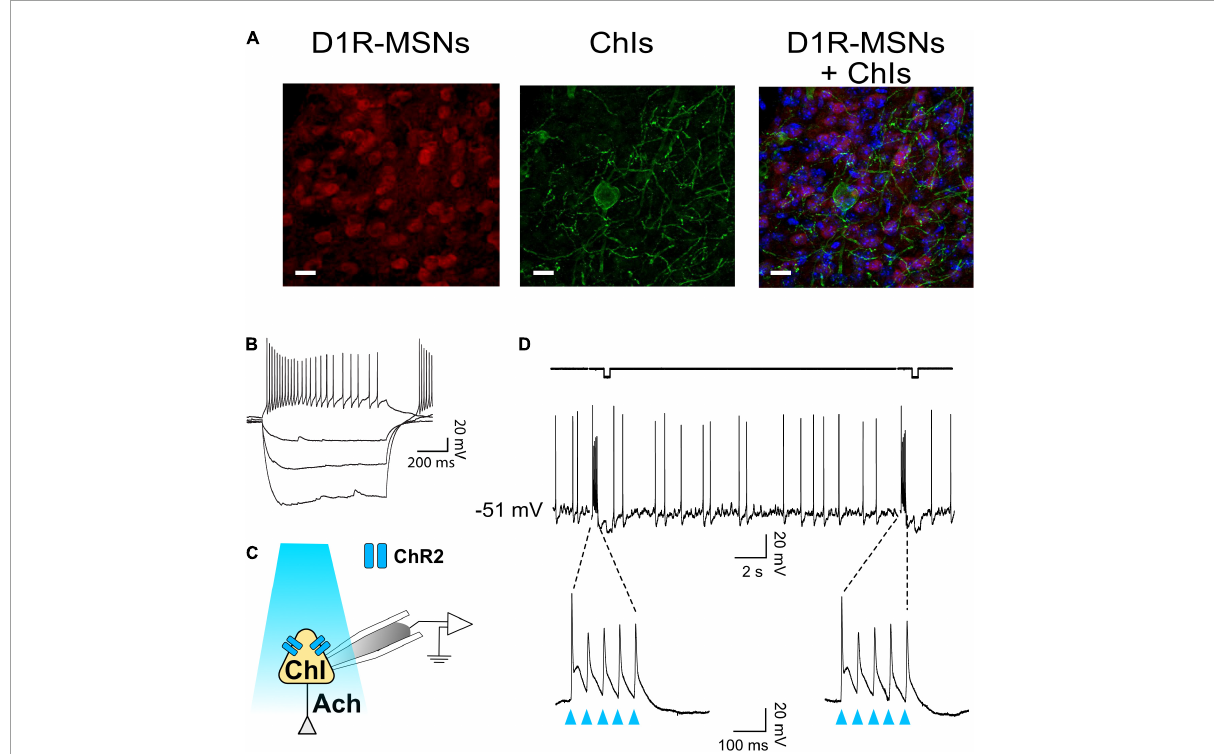
FIGURE1 ChAT-ChR2-eYFP x DrD1-tdTomato mouse line to optogenetically stimulate ChIs and differentiate core NAc D1- and D2-MSNs. (A) Immunostaining in ChAT-ChR2-eYFP x DrD1-tdTomato mouse line of D1-MSNs (left panel, red-fluorescence) and cholinergic interneurons (middle panel, eYFP fluorescence) in the nucleus accumbens. Right panel shows overlaid left and middle panels. All neurons are stained in blue. Scale bar 20 um. (B) Representative voltage traces in response to incremental current steps (–150 pA to 0 in steps of 50) in a cholinergic interneuron. (C) Schematic of ChI recording during optogenetic stimulation with blue light. (D) Optogenetic stimulation (i.e., burst of five 20 Hz pulses every 20 s for 2 min) evokes action potentials in ChI.